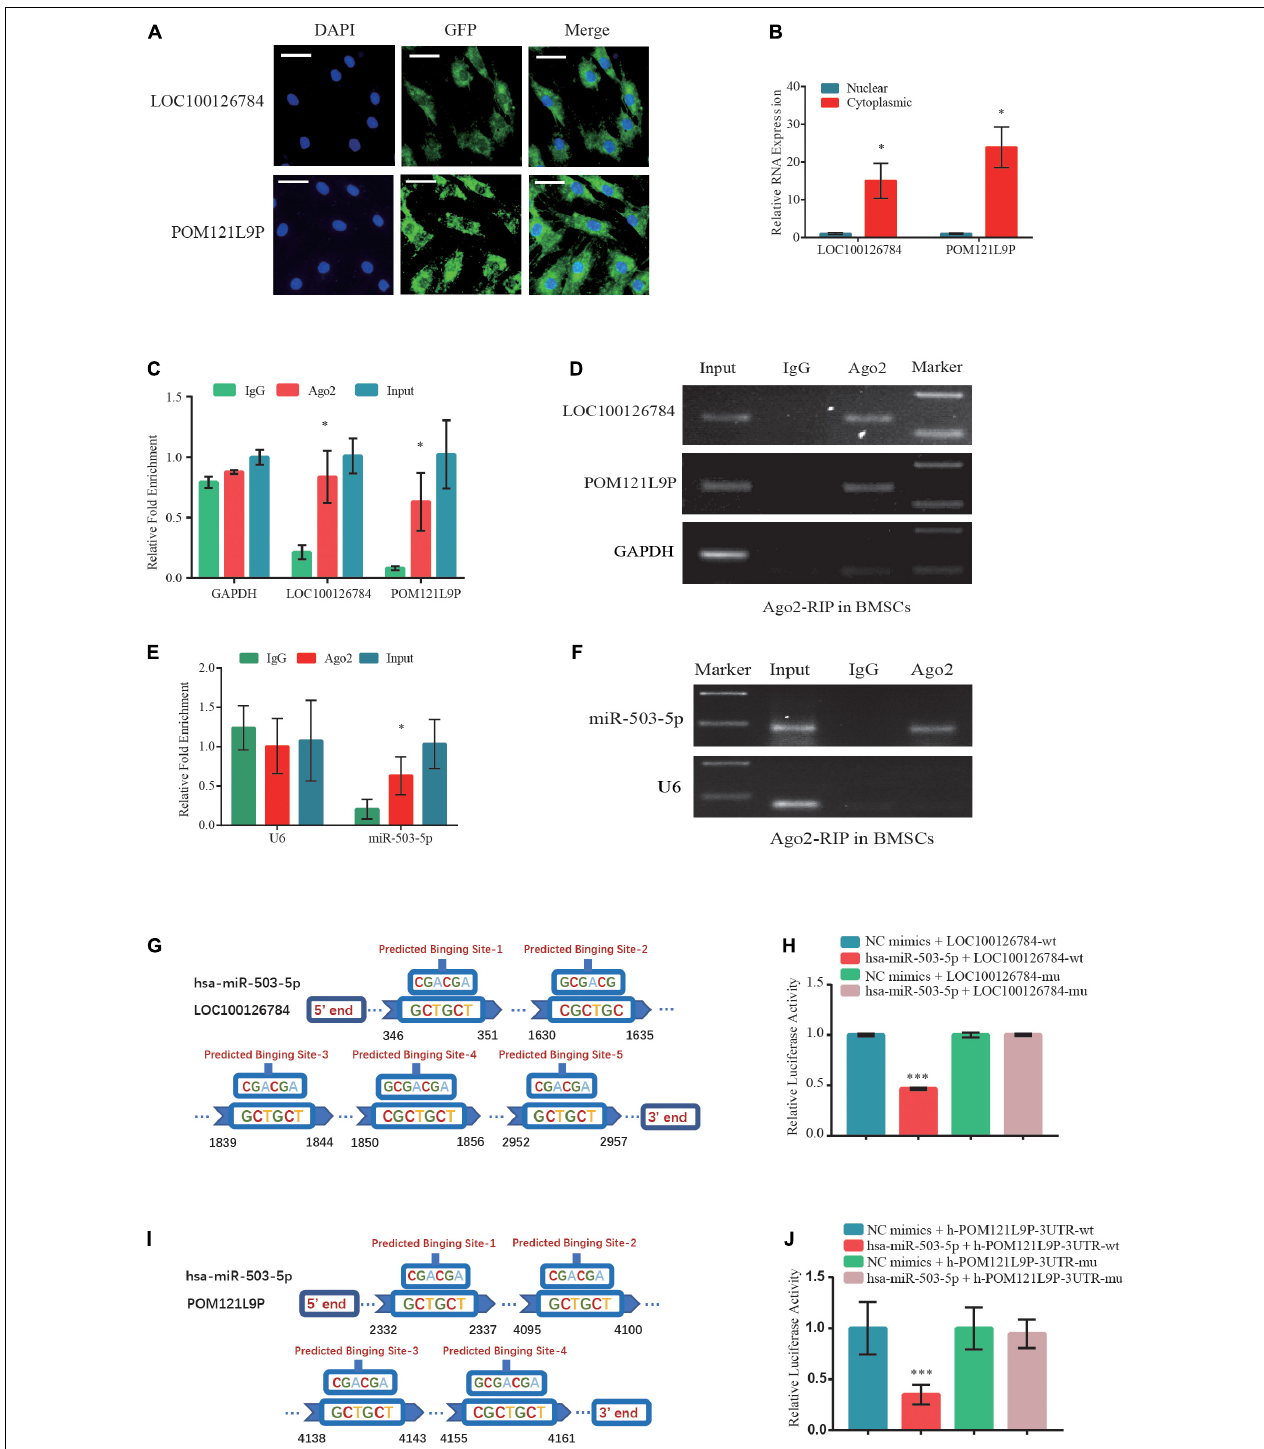
FIGURE 5 | Direct LOC100126784 and POM121L9P binding to miR-503-5p in the cytoplasm. (A) RNA fluorescence in situ hybridization (FISH) images showing the localization of LOC100126784 and POM121L9P in BMSCs. LncRNAs probes were labeled with Alexa fluor 488, and nuclei were stained with DAPI. Scale bar, 50 µ m. (B) RNA-binding protein immunoprecipitation (RIP) assay of Ago2 vs. IgG enrichment on LOC100126784, POM121L9P (C,D) and miR-503-5p (E,F) in BMSCs and detection by RT-qPCR and gel electrophoresis. Predictions of target binding sites of LOC100126784/miR-503-5p (G) and POM121L9P/miR-503-5p (H) . HEK293T cells co-transfected with miR-503-5p or control-mimics and luciferase reporter constructs containing WT or MUT of LOC100126784 (I) or POM121L9P (J) . ∗ p < 0.05, ∗∗∗ p < 0.001.